Question: Compose a caption that would accompany this figure in a paper.
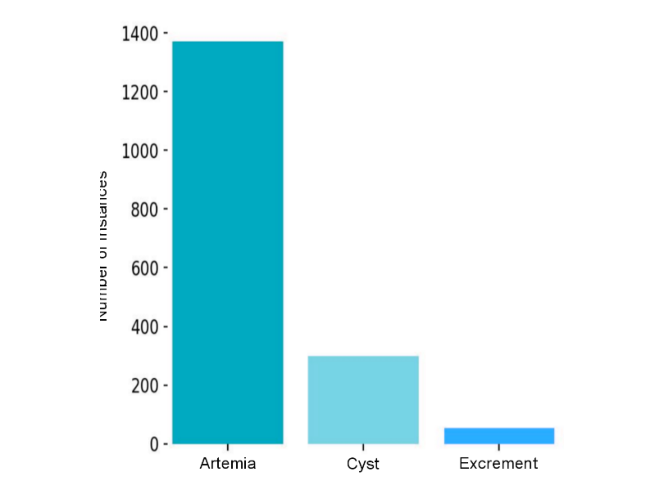
Answer: Number of class-instances